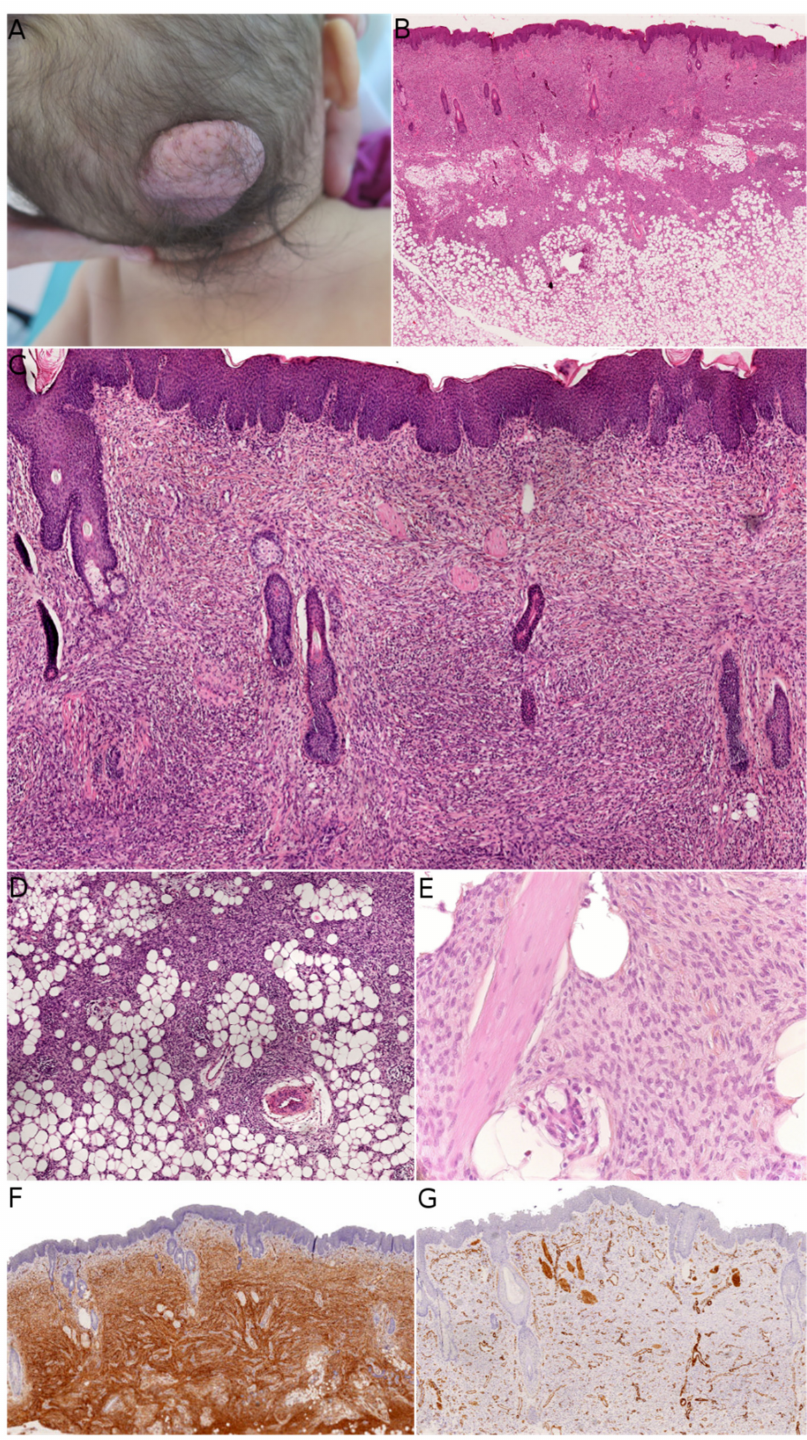
Figure 1. Fibroblastic connective tissue nevus. ( A ) Clinical presentation on the scalp of an in- fant (courtesy of the Department of Maxillofacial Surgery, Necker-Enfants Malades hospital, Paris, France). ( B ) Low-power view of the lesion showing infiltration of the dermis and subcutis (HE × 50). ( C ) Short intersecting fascicles surrounding the appendages and epidermal hyperplasia (HE × 100). ( D ) Extension into the subcutis (HE × 100). ( E ) High-power view showing the bland morphology of the spindle cells (HE × 200). ( F ) Diffuse positivity for CD34 ( × 50). ( G ) In this case, smooth muscle actin was negative, with internal controls on vessels and smooth muscles ( ×